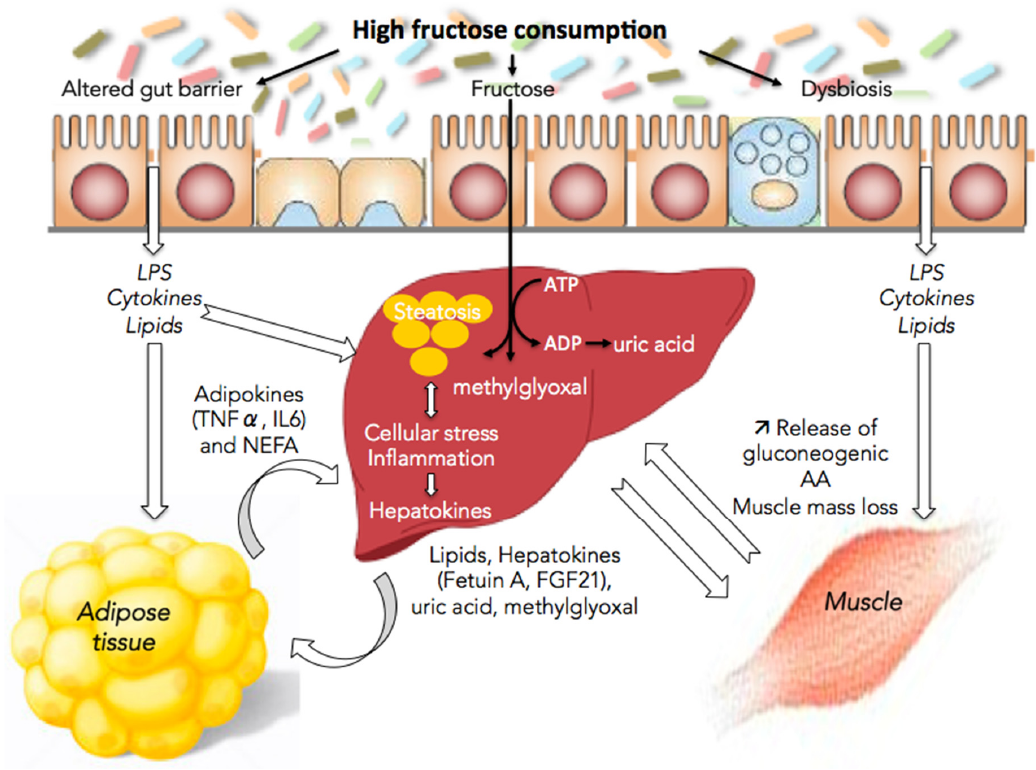
Figure 1. Fructose and nonalcoholic fatty liver disease (NAFLD): the multifaceted aspects of fructose metabolism. Excessive fructose consumption is associated with hepatic steatosis, cellular stress and inflammation. This is responsible for the release by the liver of lipids, methyglyoxal, uric acid, and hepatokines leading to alterations in the communication between the liver and the gut, muscles, and adipose tissue and to disease aggravation. LPS, lipopolysaccharides; TNF α , tumor necrosis factor α ; IL6, interleukin-6; NEFA, non-esterified fatty acid; ATP, adenosine triphosphate; ADP, adenosine diphosphate; FGF21, fibroblast growth factor 21; AA, amino acids.